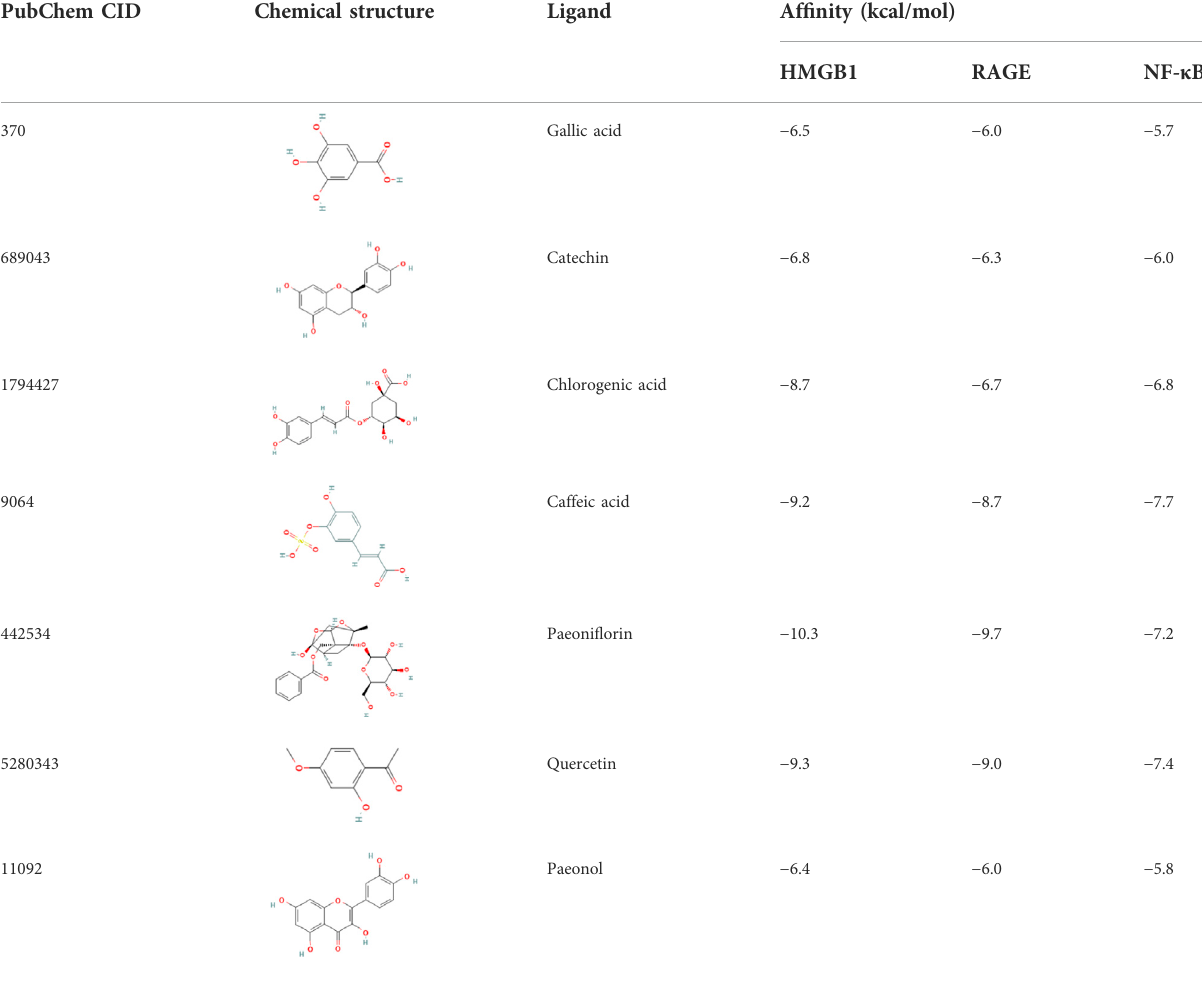
TABLE 4 Molecular docking simulations between HMGB1/RAGE/NF- κ B and the seven components of BF. PubChem